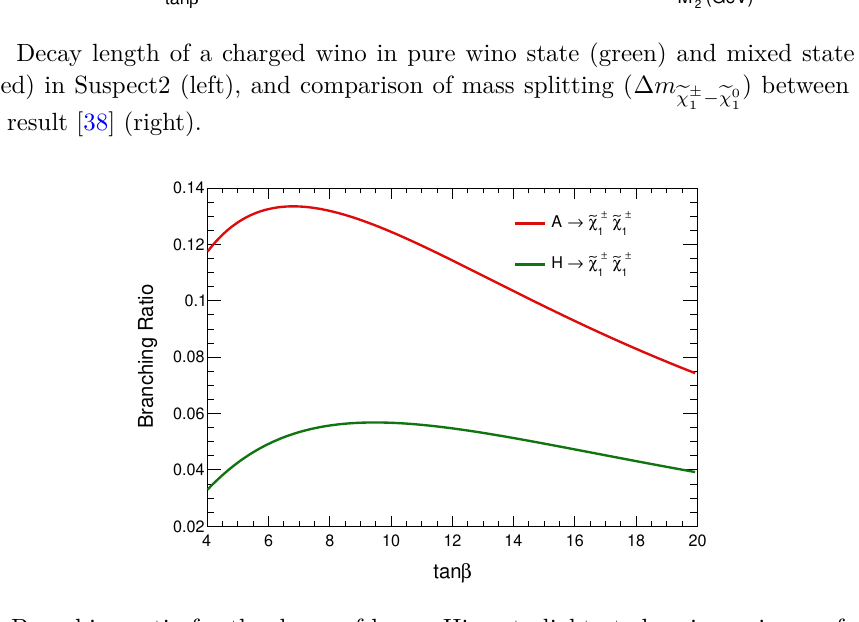
Figure 6. Branching ratio for the decay of heavy Higgs to lightest chargino pair as a function of tan β with fixed, bino, wino and higgsino parameters at M 1 = 1000 GeV , M 2 = 300 GeV , µ = 500 GeV